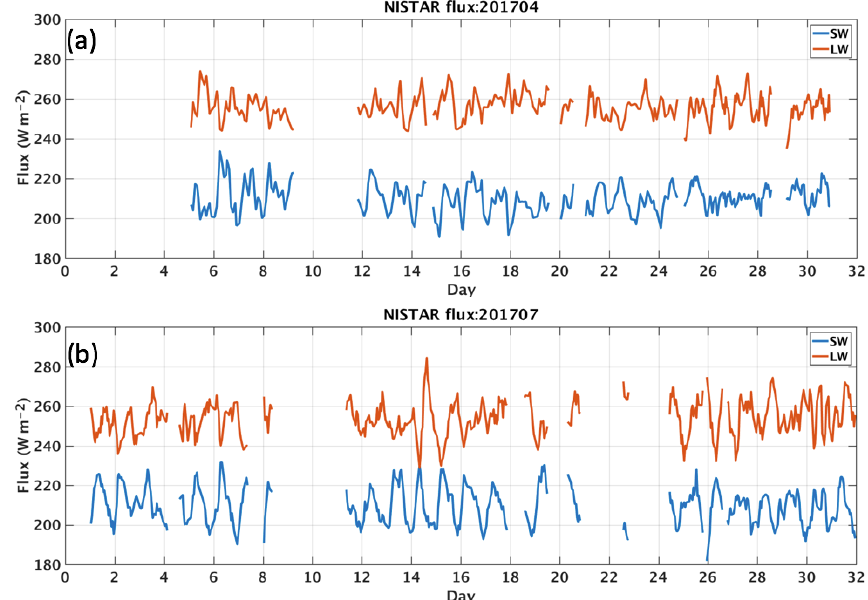
Figure 5. SW flux (blue) and LW flux (red) derived from NISTAR measurements for April (a) and July (b)